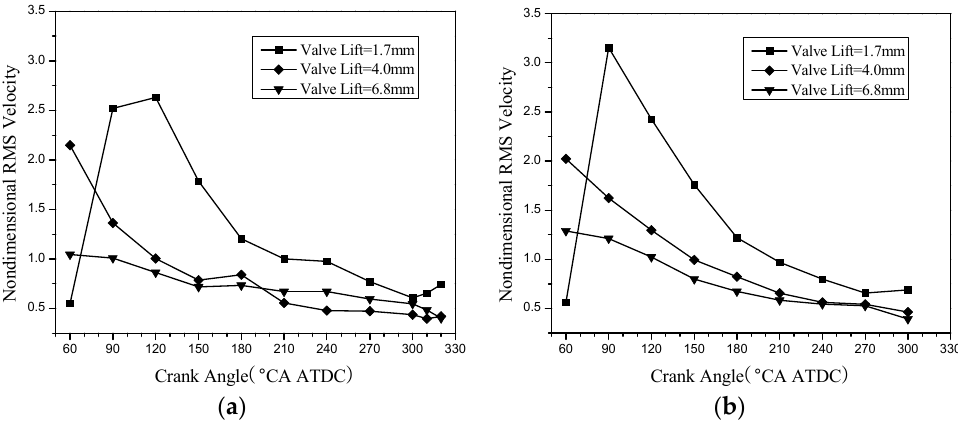
Figure 10. Variations of total low-frequency non-dimensional RMS fluctuating velocity of swirl flow with CA for three MVLs (at ( a ) 5 mm and ( b ) 15 mm plane).